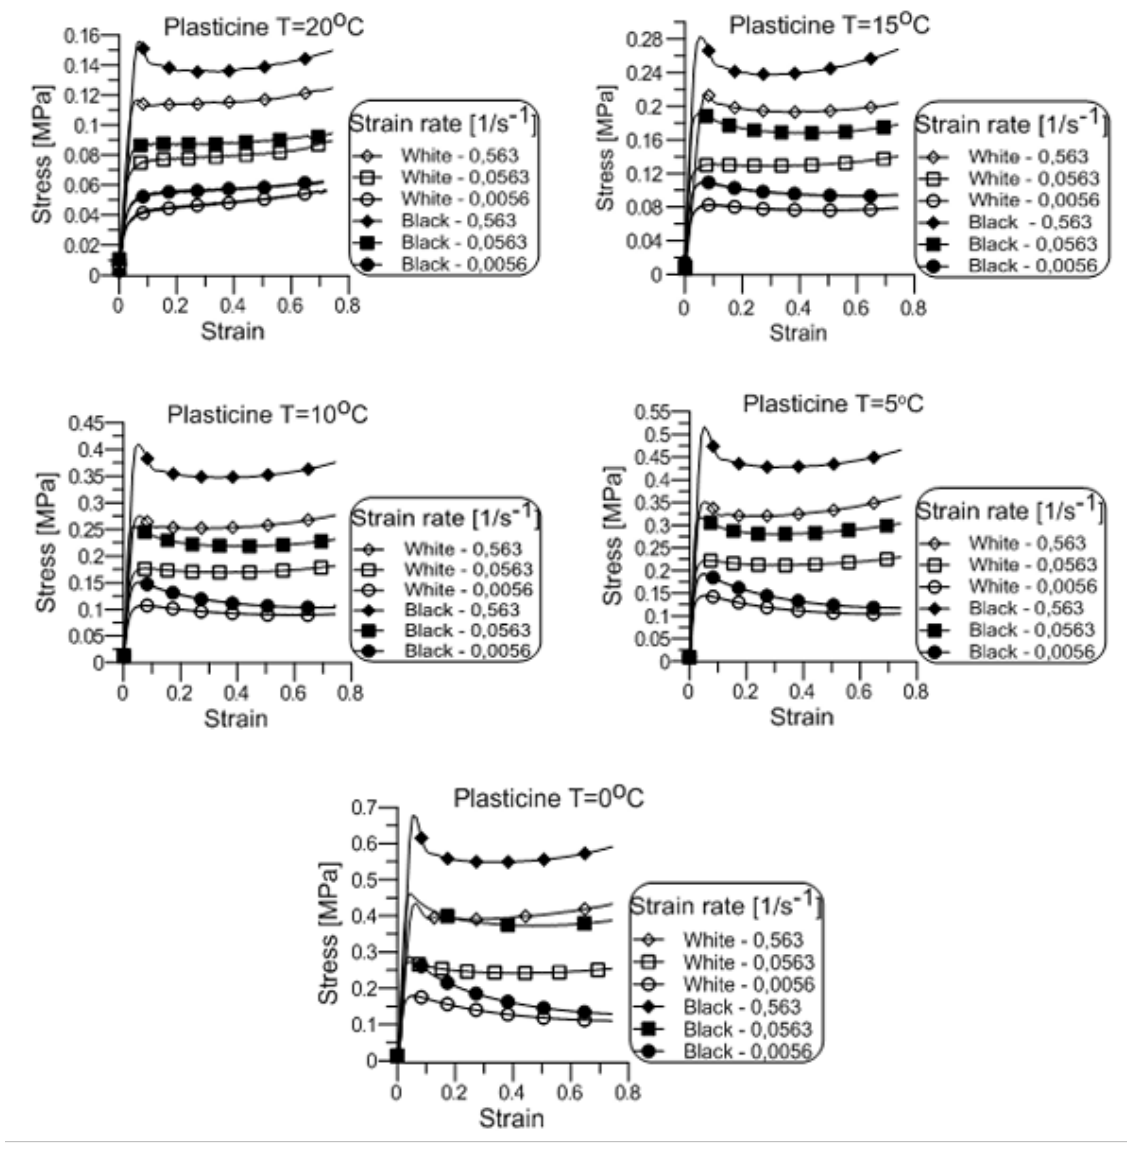
Figure 4: Plasticine flow curves.